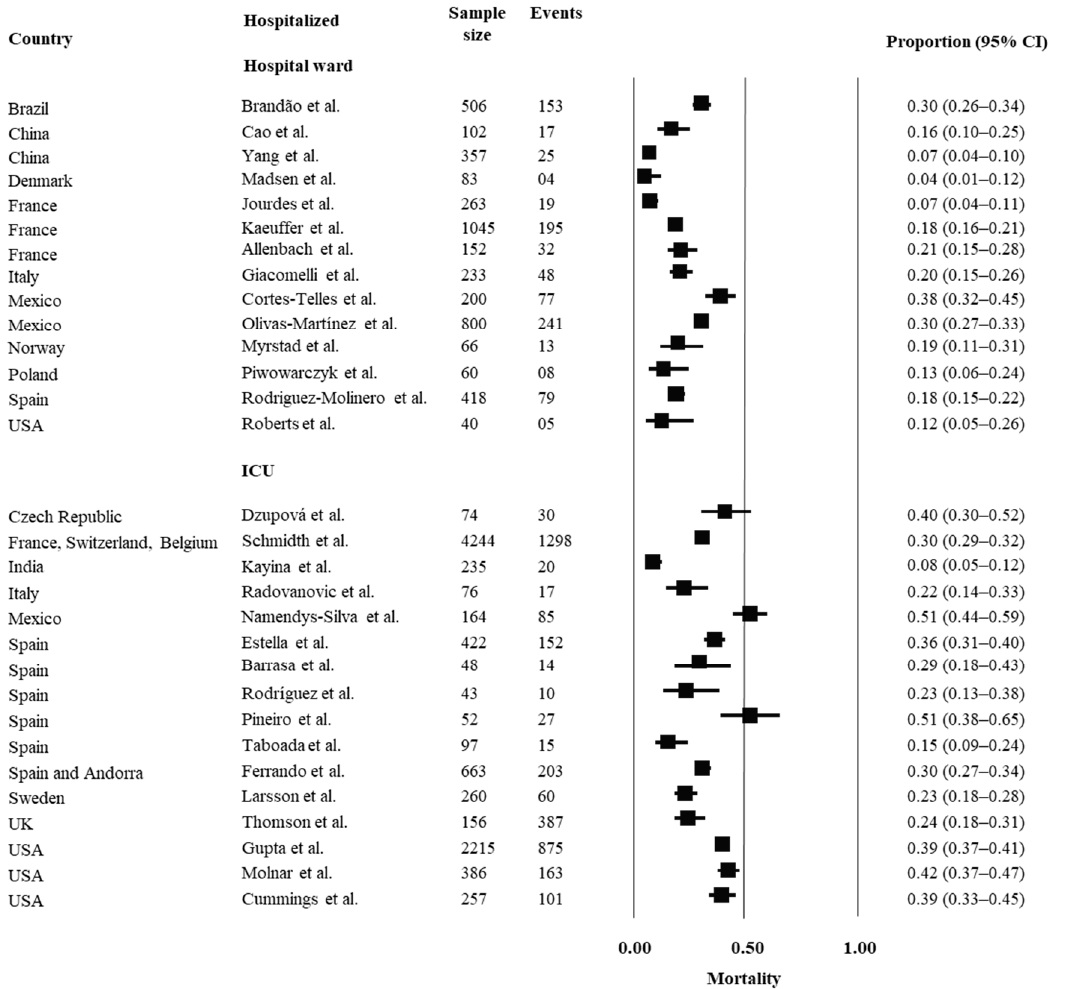
Figure 2. Prognosis of mortality in hospitalized people with COVID-19. For analysis, the studies were grouped by country and by hospital setting (hospital ward or ICU). Estimates of proportions for dichotomous data, considering the number of events and sample size, were reported. Abbreviations: USA = United States of America; UK = United Kingdom; IC = confidence interval. References: